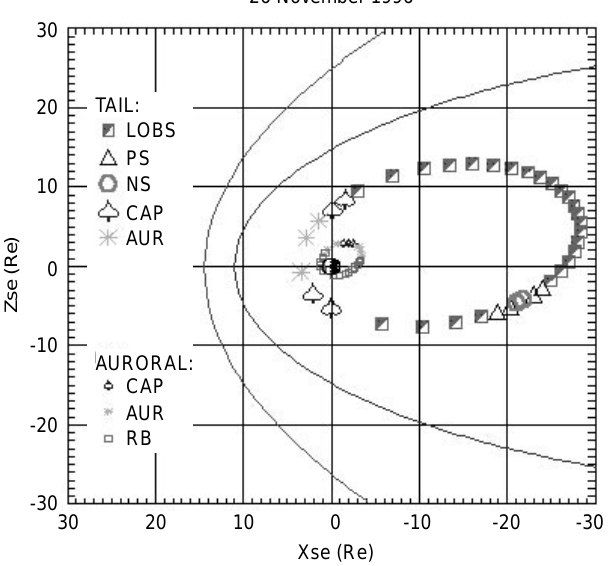
Fig. 2. Orbits of the Interball Tail and Auroral Probes on 26 November 1996, projected onto the noon-midnight meridian plane, in solar-ecliptic coordinates. Xse points towards the Sun. Average models of the bow shock and the magnetopause are indicated. Along the orbit of the Tail Probe, the computed position of the tail lobe (LOBS), plasma sheet (PS), neutral sheet (NS), polar cap (CAP), and auroral zone (AUR) are indicated on the left side of the figure by symbols with di(cid:128)erent colours. The same presentation is used for the orbit of the Auroral Probe. (Courtesy of V. Prokhorenko)